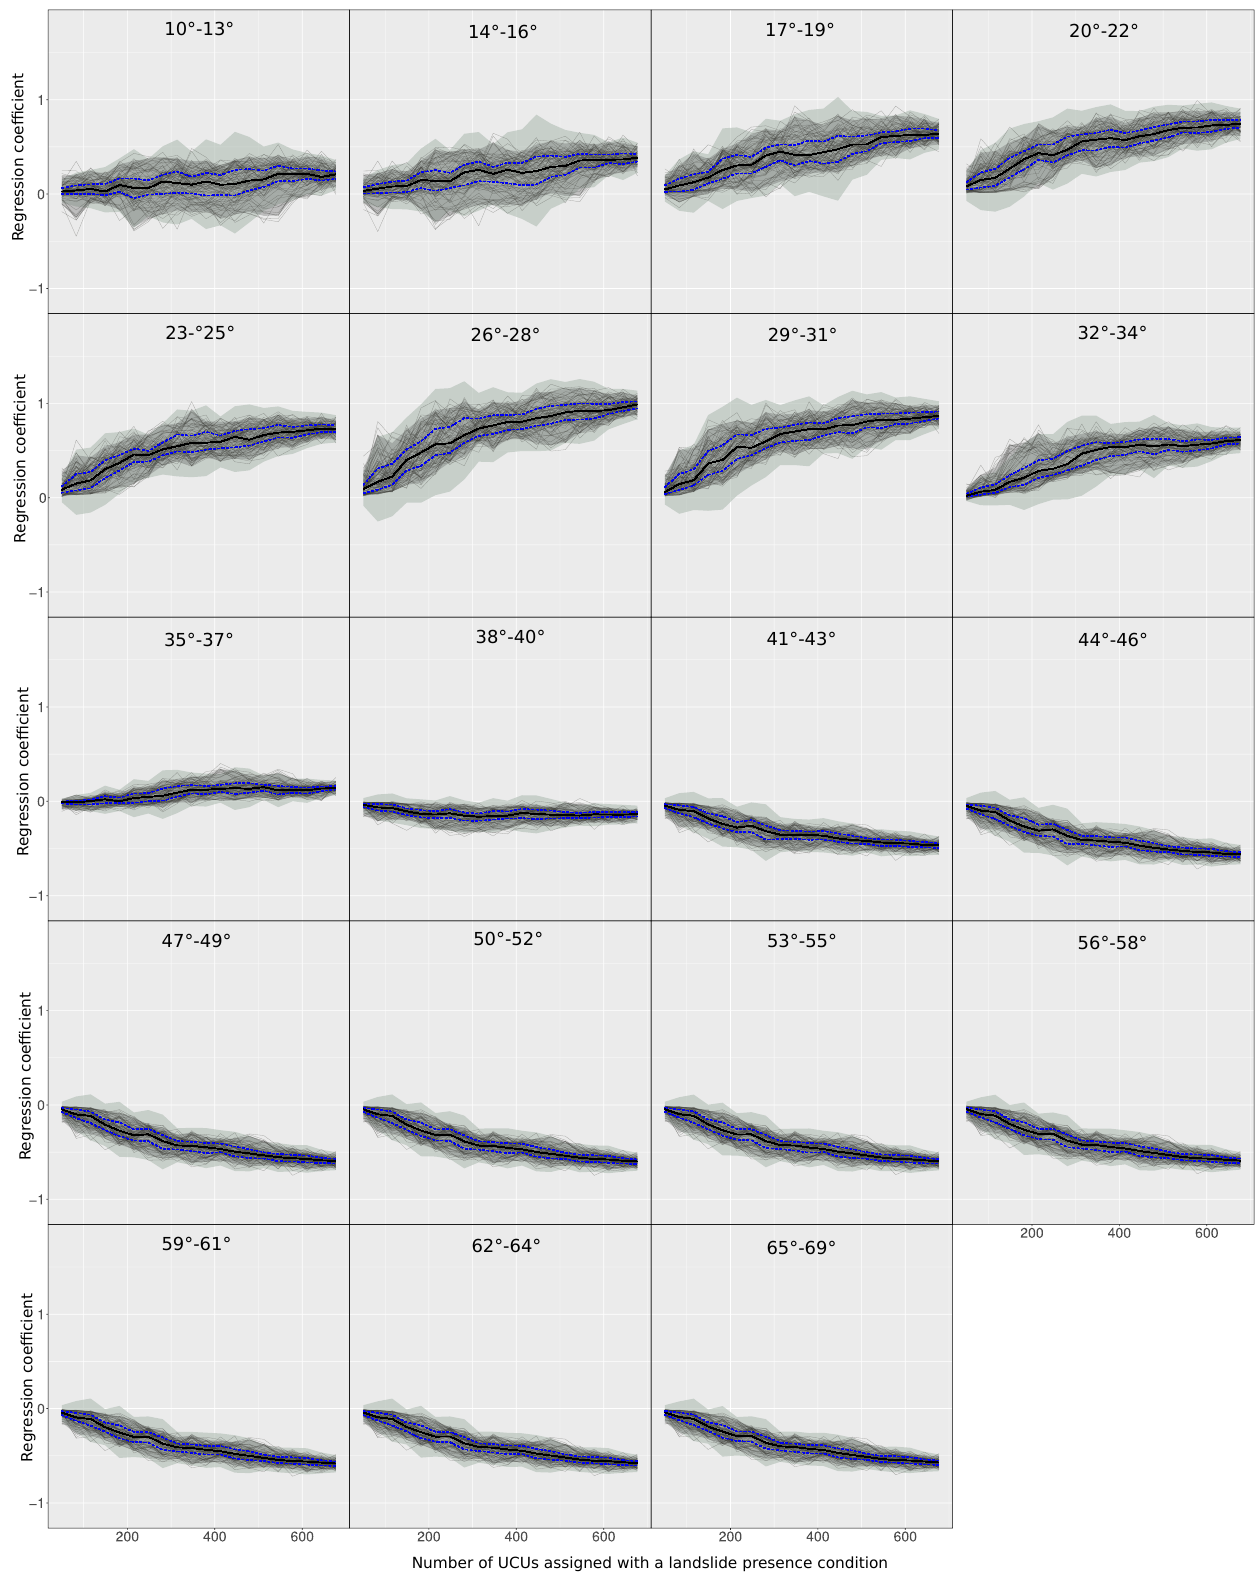
Figure A3. Mean slope effect graphical summary at a varying proportion of landslide presence